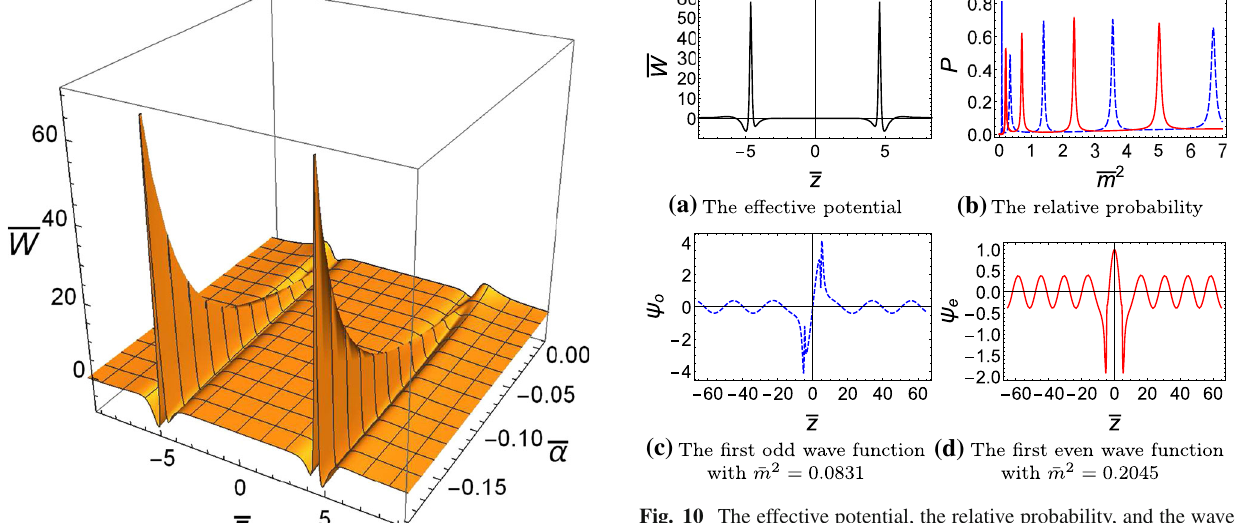
Fig. 10 The effective potential, the relative probability, and the wave functions of the first odd and even KK resonances with ¯ b = 10 and ¯ α = − 0 . 19 for case 1